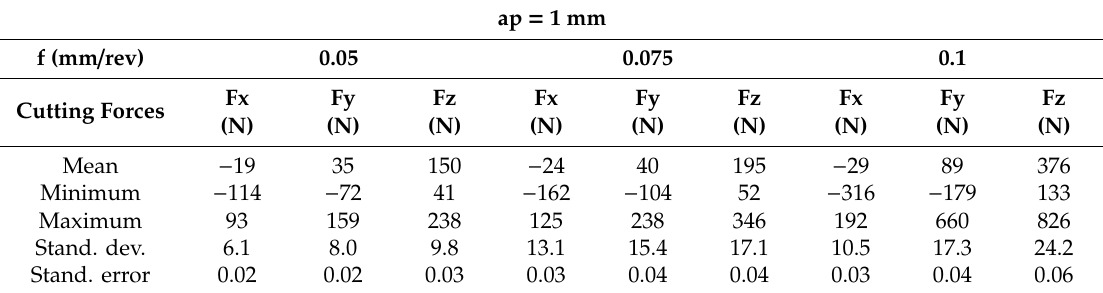
Table 3. Statistical analysis of cutting forces for ap = 1 mm.